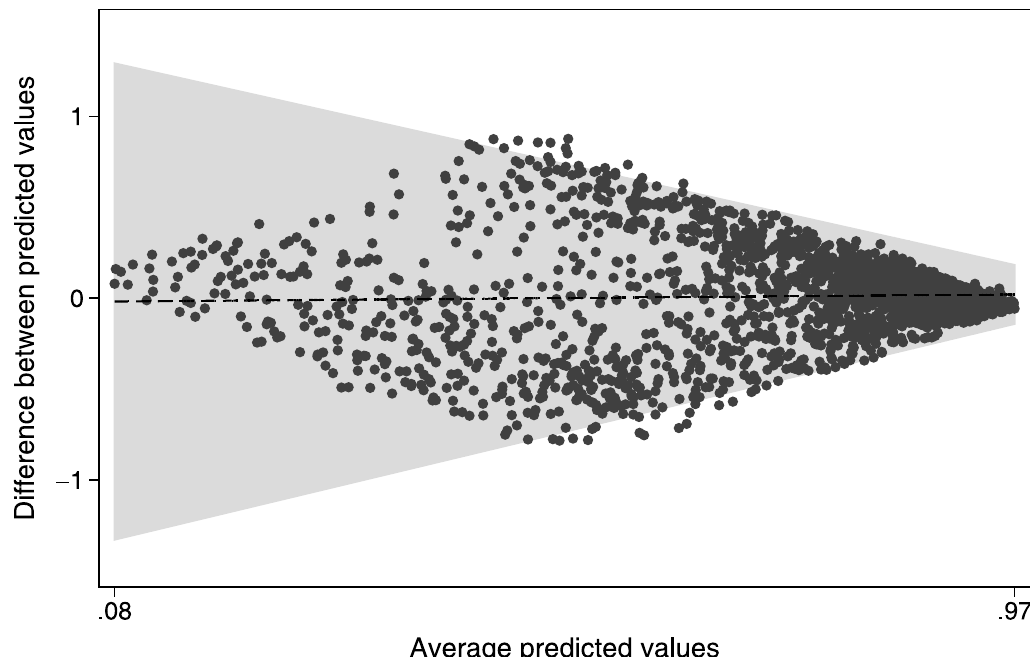
Fig 2. Bland Altman Plot of agreementbetween registry and administrative risk standardization models.